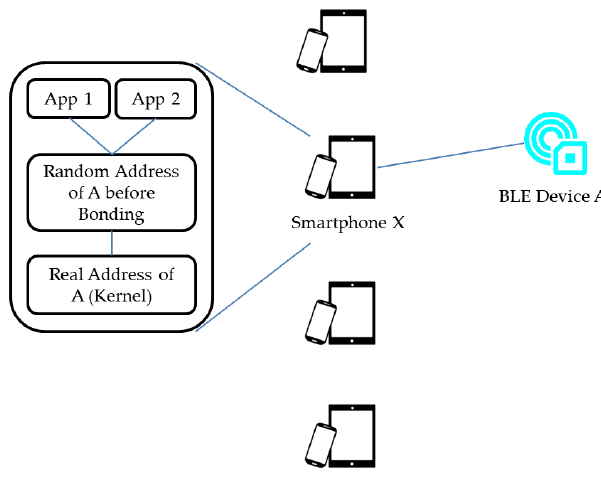
Figure 1. A potential security impact of adopting the random address technique.